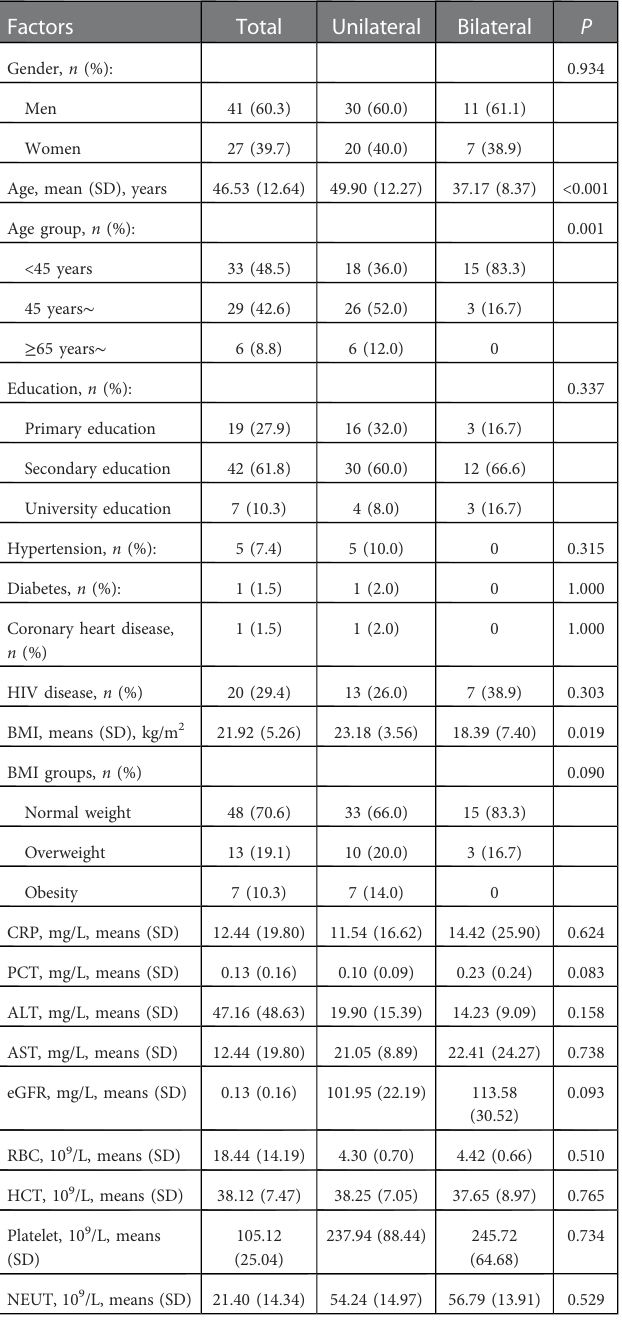
TABLE 2 The security evaluation among patients in unilateral and bilateral. Factors Unilateral Bilateral P